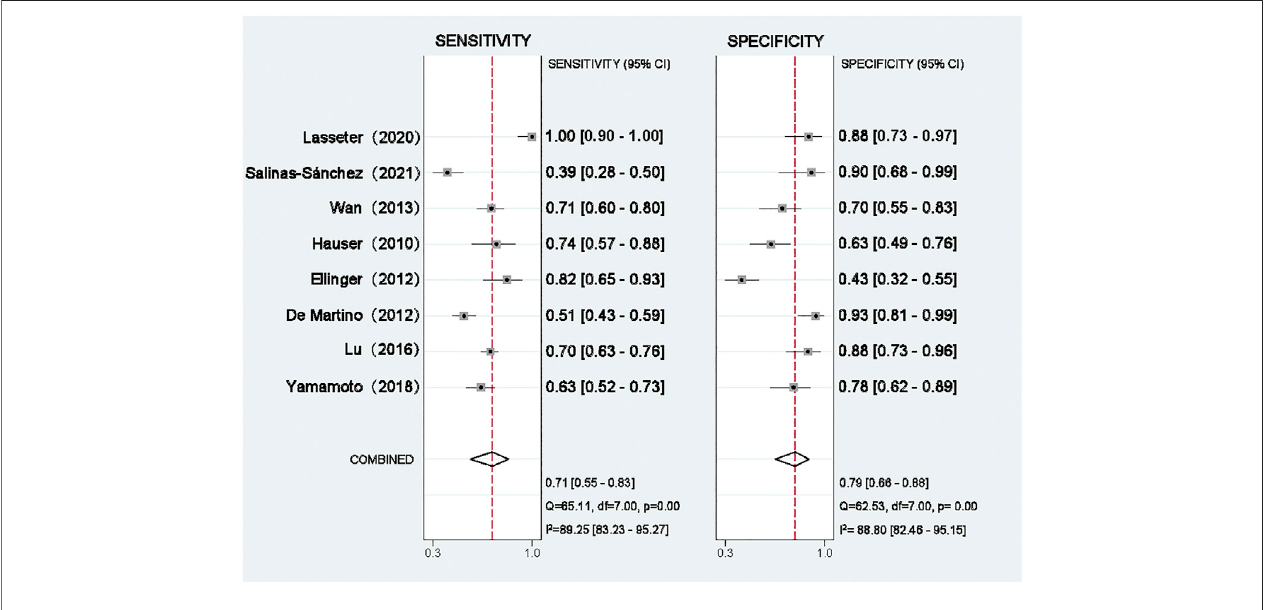
FIGURE 3 | Forest plot of the pooled sensitivity and speci fi city.